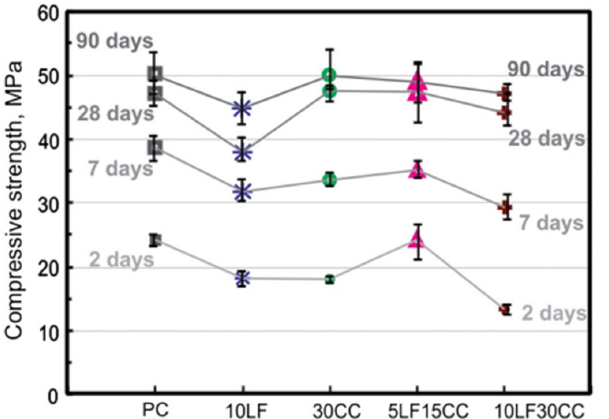
Figure 8. Compressive strength of mortar at different ages. Reprinted with permission from Ref.